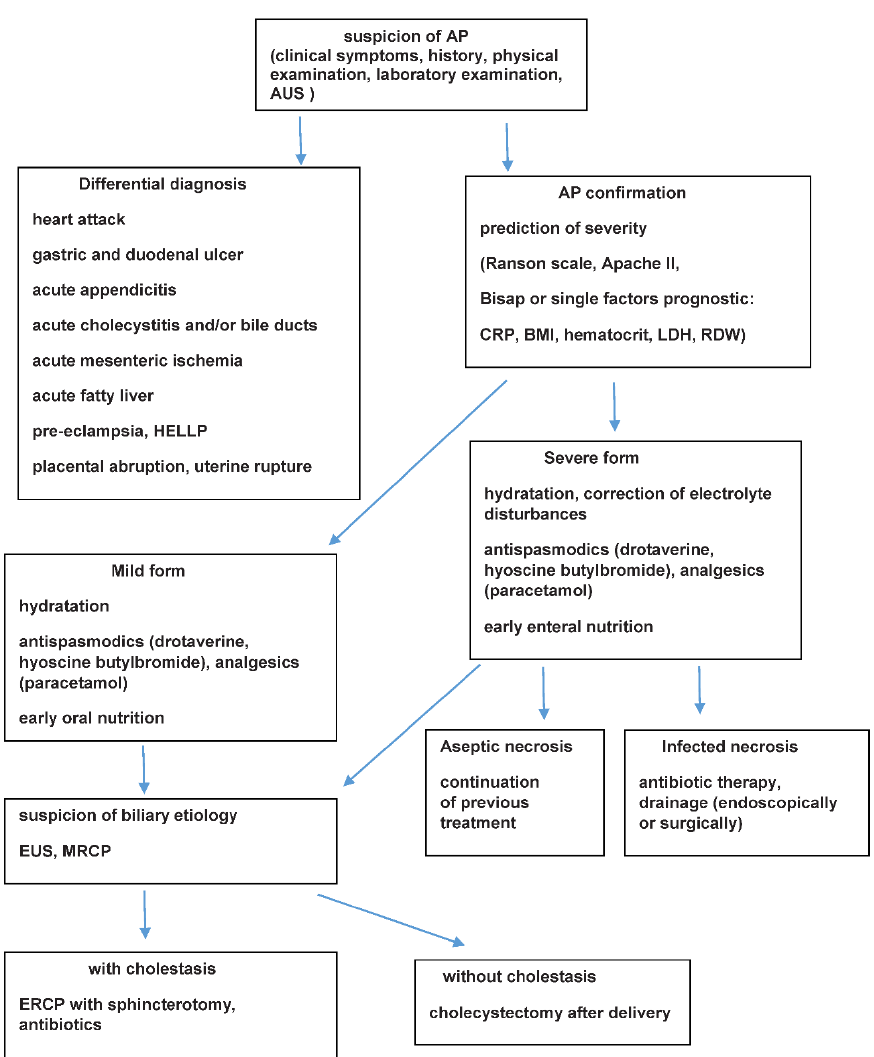
Figure 1. Schematic algorithm concerning management of AP in pregnant women. AP (acute pancreatitis); AUS (abdominal ultrasonography); BMI (body mass index); CRP (C-reactive protein); ERCP (endoscopic retrograde cholangiopancreatography); EUS (endoscopic ultrasound); HELLP (hemolysis, elevated liver enzymes low platelts); LDH (lactate dehydrogenase) ; MRCP (magnetic resonance cholangiopancreatography); RDW (red cell distribution width).